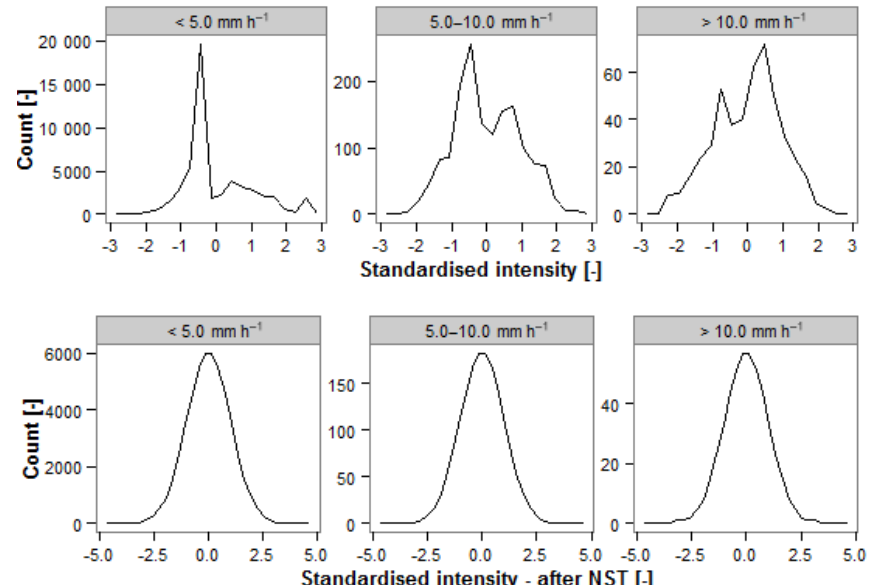
Figure 6. Distribution of standardised rainfall intensity for different rainfall intensity classes at a temporal averaging interval of 5min before (upper part) and after (lower part) normal score transformation